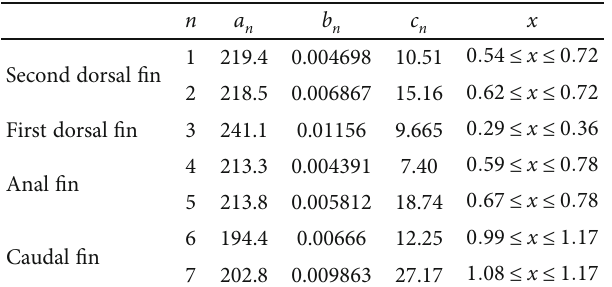
Figure 1: The physical prototype of a yellow fi n tuna. (a) Scanning the physical prototype with a 3D scanner; (b) the point cloud image; (c) the fi tting curves of the tuna model. Table 1: The fi tting curve